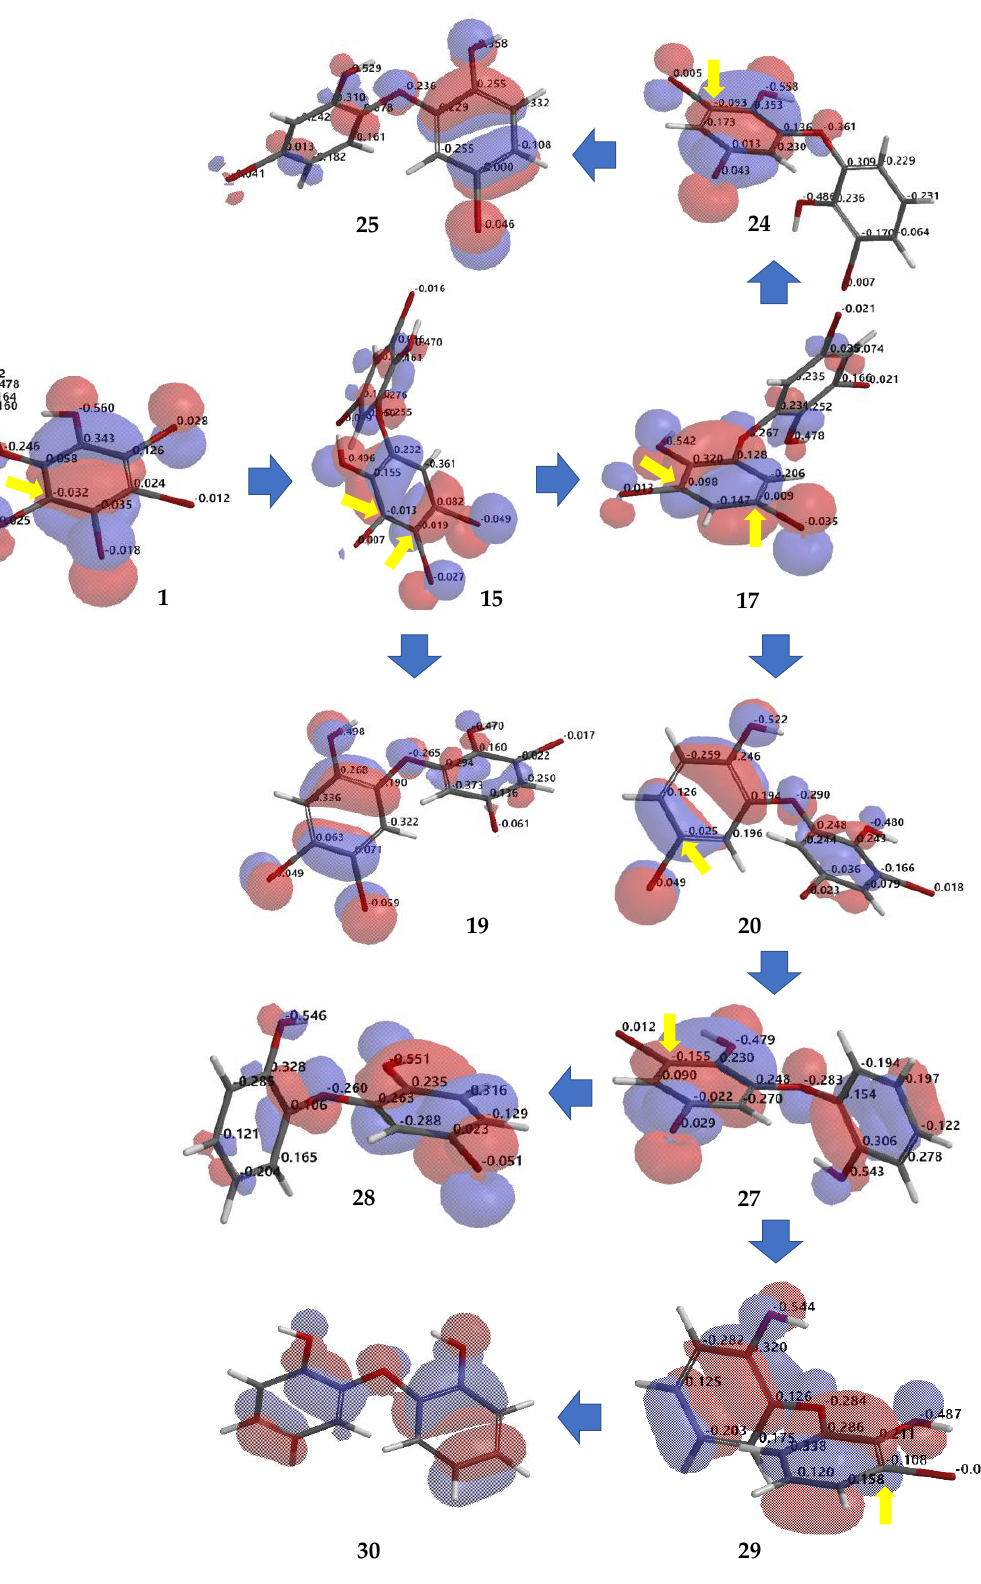
Figure 7. Analysis of frontier molecular orbital (HOMO) and electrostatic charges for 1 , 2 , 14 , 16 – 18 , 20 , 23 , 26 calculated using DFT ω B97X-D/6-311+G(2d,p). The yellow arrow shows the reactive site for the debromination reaction possessing negative charges in HOMO